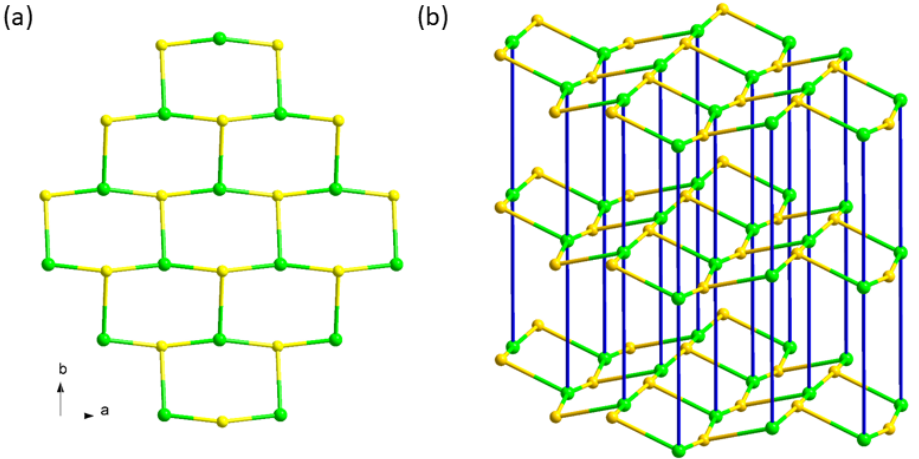
Figure 3. ( a ) Schematic representation of the 3-connected 2D net of Ni(II)-CrO 4 layer, and ( b ) the binodal (3,5)-connected hms topology of compound 1 . The Cr, Ni centers are shown as yellow and green spheres, respectively, and bpym ligands are represented by blue sticks.